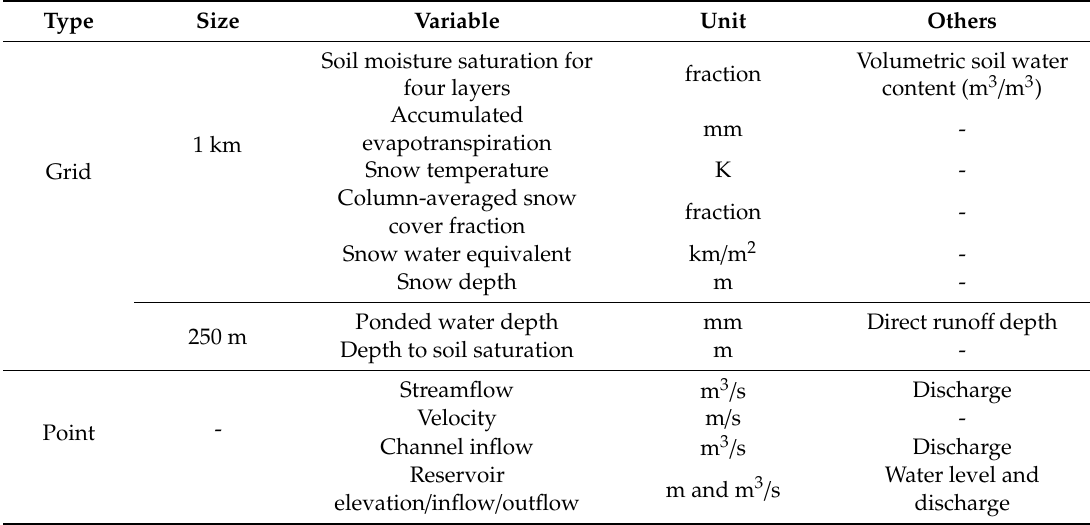
Table 1. Features of hydrological products produced by the National Water Model